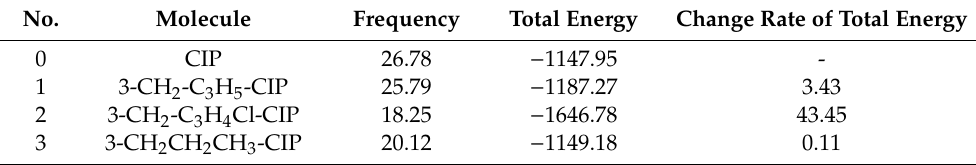
Table 5. Calculation values of frequency and total energy of the CIP derivatives.